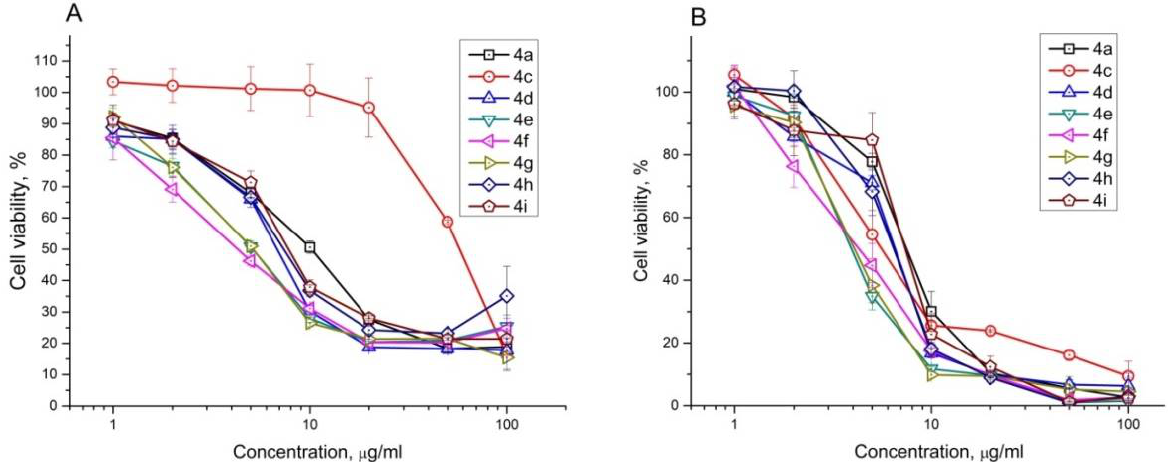
Figure 4. Cytotoxicity of 3-azaspiro[bicyclo[3.1.0]hexane-2,5′-pyrimidines] 4a,c–i against Jurkat cell line for 24 h ( A ) and 72 h ( B ).